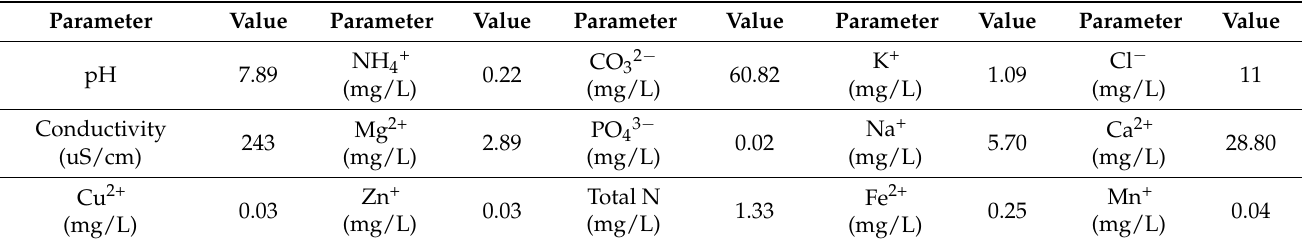
Table 3. Water quality parameters of Yangling tap